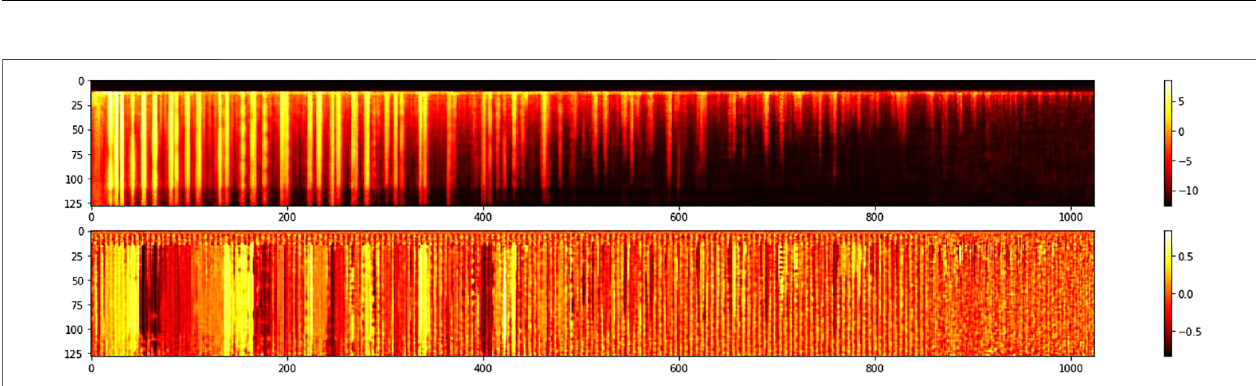
FIGURE 2 | MFCC representation of a forte chord used for training. The horizontal dimension represents time while the vertical dimension encodes frequency coef fi cients. Brighter yellow colors represent higher sound intensities. The top graph shows the magnitude of the frequency representation and the bottom displays its phase.